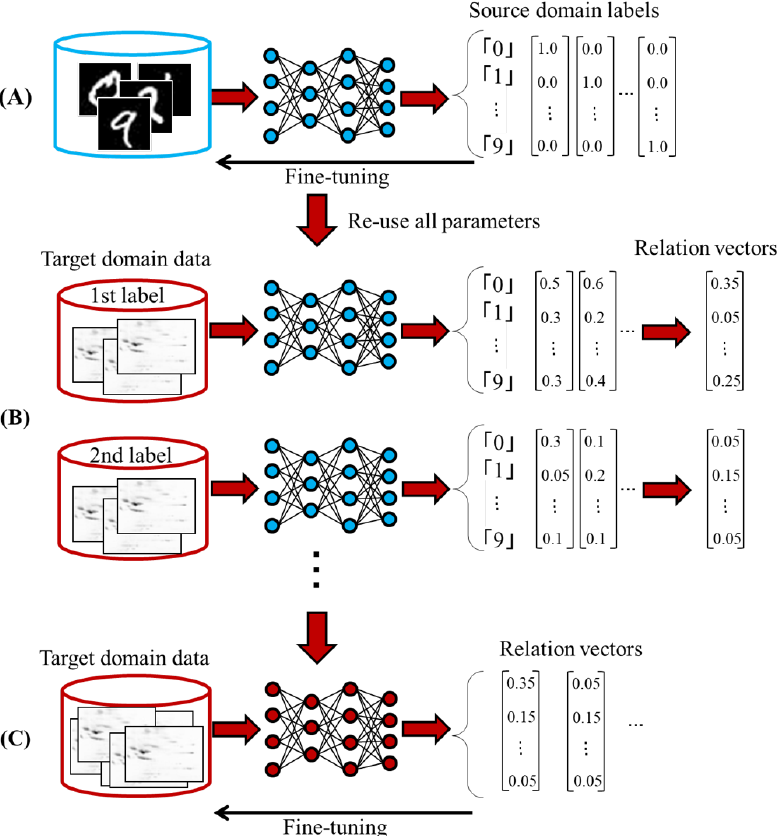
Figure 1. Outline of our proposed method. ( A ): Training the deep neural network (DNN) using the source domain data, ( B ): estimating the relation vectors of each target domain label, ( C ): tuning all the parameters using pairs of target domain data and relation vectors.